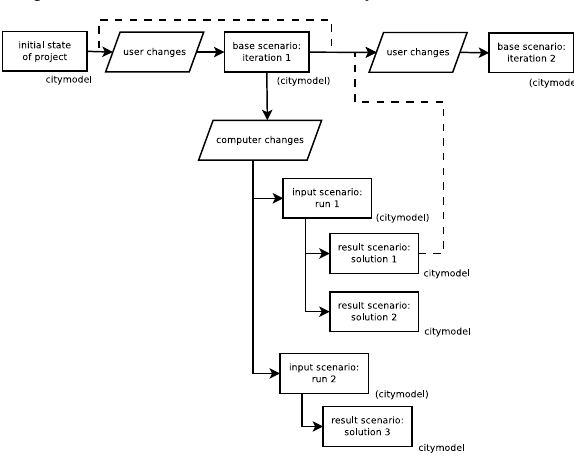
Figure 2. UML diagram of the data model for interactive optimization and its relation to the CityGML Scenario ADE